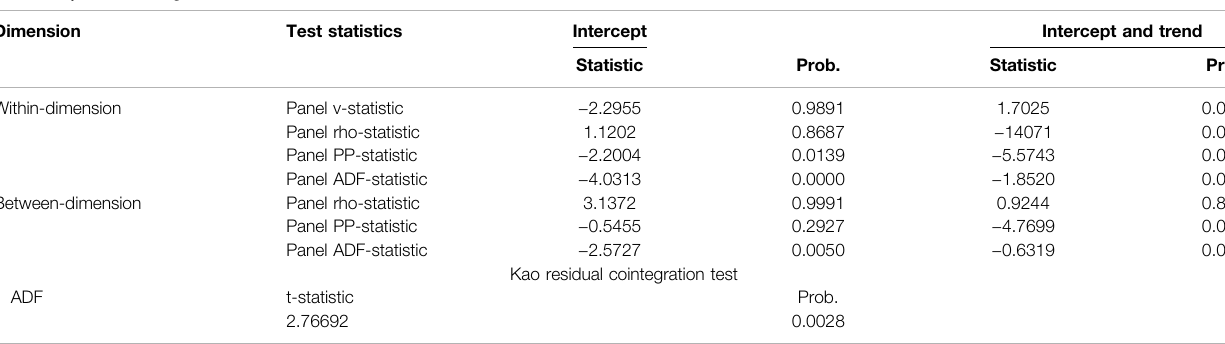
TABLE 3 | Panel cointegration tests.